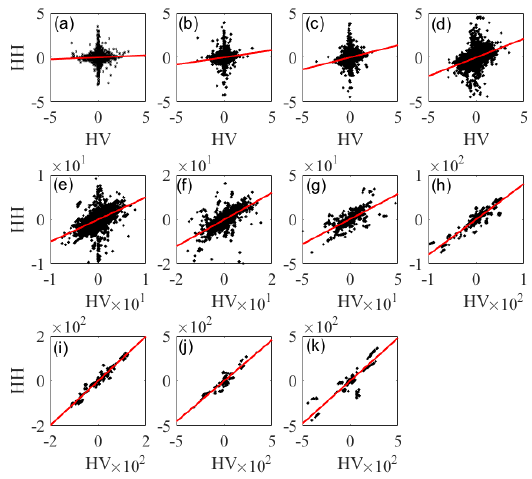
Figure 5. Scatter plots (HV vs. HH) of the wavelet coefficients in horizontal direction ( a – k indicates the wavelet decomposition scales ranging from 1 to 11).